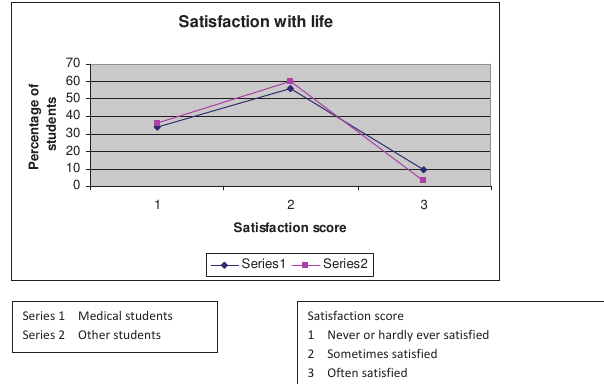
Fig. 2. Subjective experience of